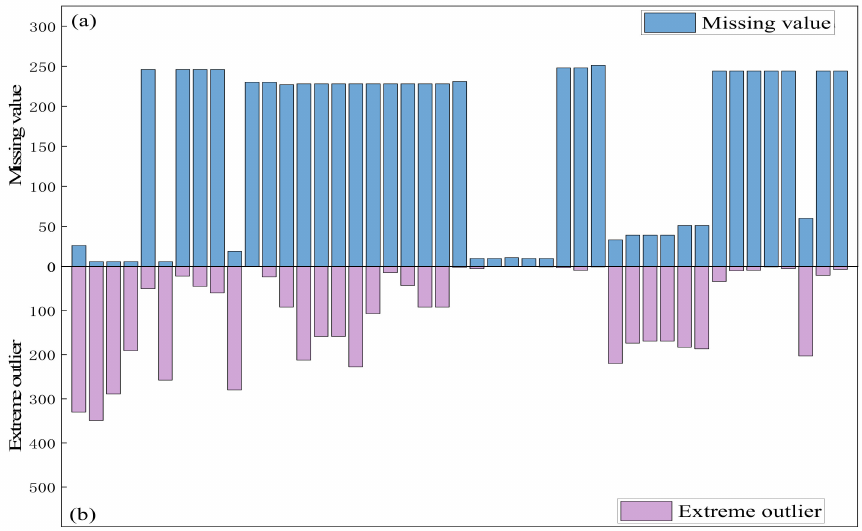
Figure 4. Number of extreme outliers ( a ) and missing values ( b